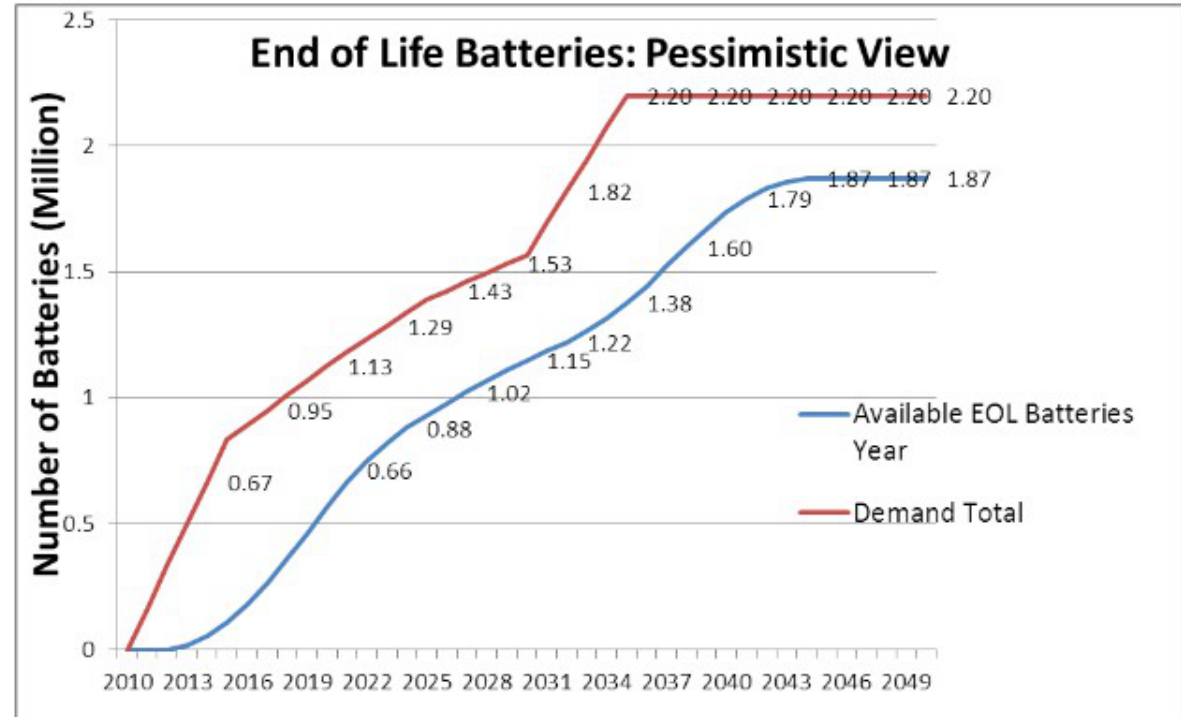
Figure 4. Pessimistic View of the Number of Available End of Life Batteries based on EIA (2010)